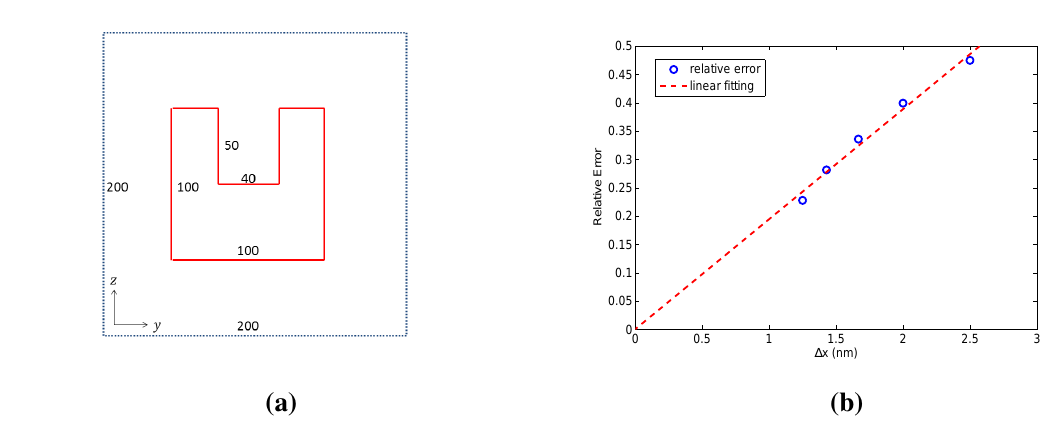
and E components of the electric field x y